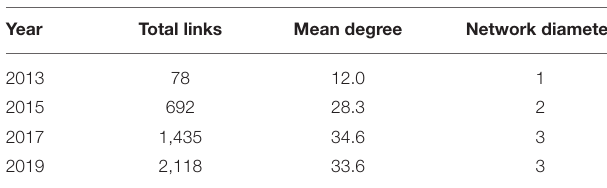
TABLE 2 | Cumulative network statistics for the workshop co-attendance network from 2013 to